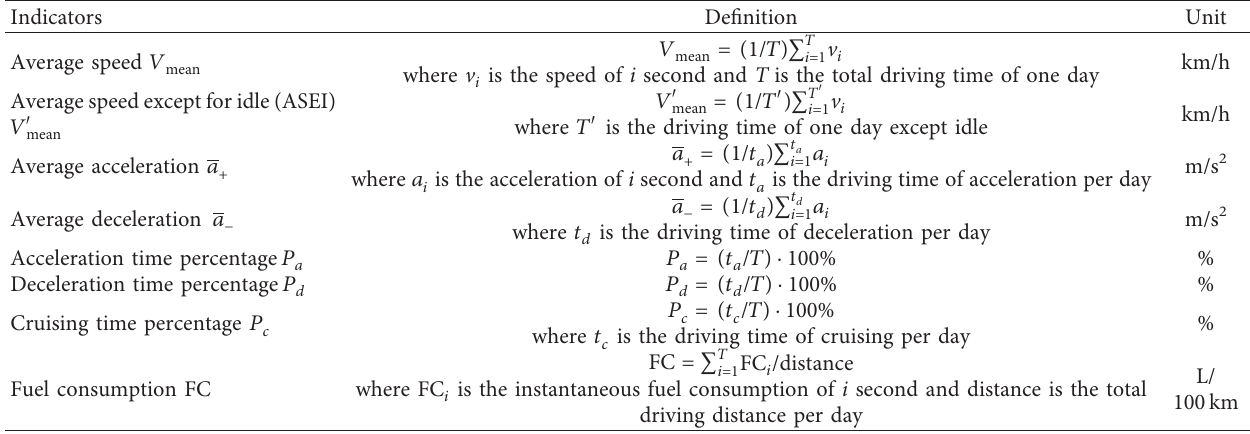
Table 2: Related indexes to predict fuel consumption.